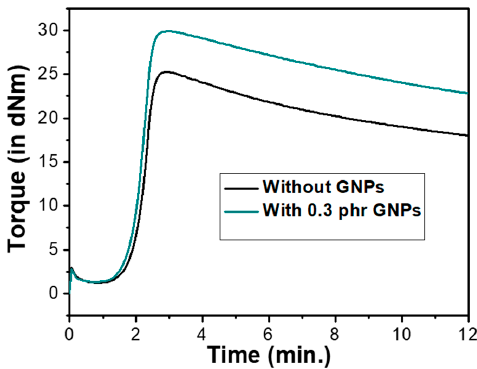
Figure 3. Cross-section SEM images of the graphene nanoplates@natural rubber latex composite.